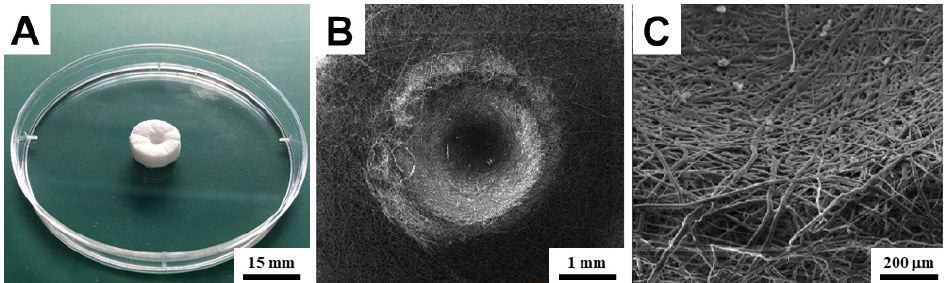
Figure 3. Three-dimensional scaffolds with a pressed trap hole. ( A )—image of scaffolds with a pressed hole. ( B )—SEM image of a pressed hole. ( C )—SEM detail image of the hole wall.